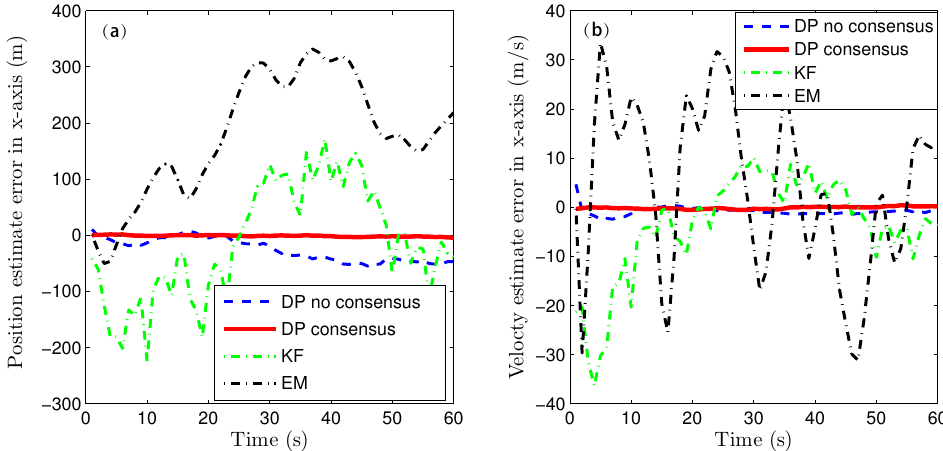
Figure 14. State estimation errors in the x direction using the KF, DP consensus, DP no consensus and EM methods for sensor 4 in the multi-sensor system of 60 sensors. ( a ) position estimation; ( b ) velocty estimation.